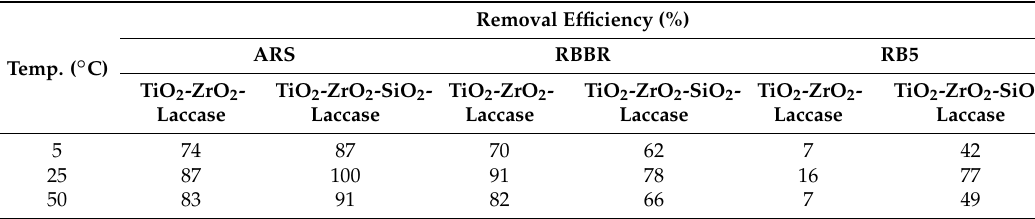
Table 4. Removal efficiencies of dyes from solutions at different temperature conditions after 24 h of the process (concentration of dyes solution 5 mg/L, pH 5). The errors of all measurements do not exceed 5%.